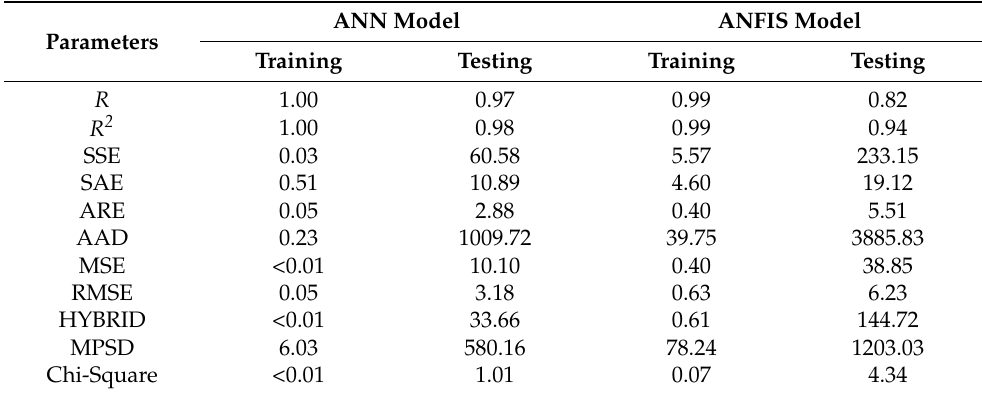
Table 4. Statistical analysis of the ANN and ANFIS